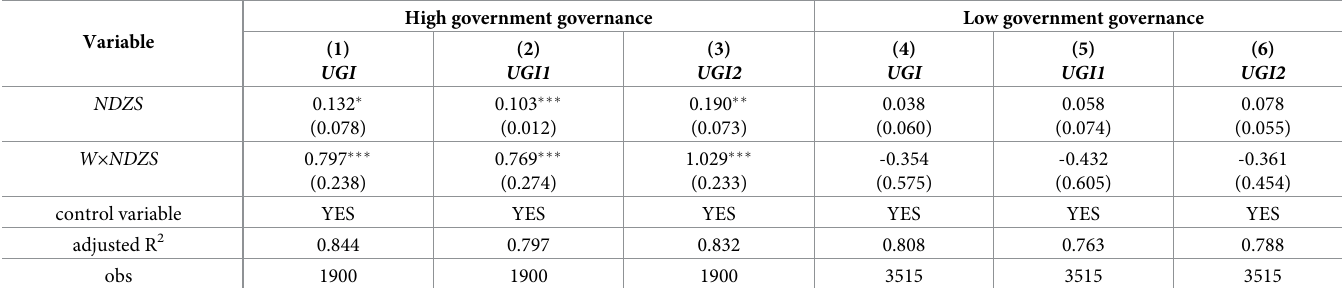
Table 7. Heterogeneity test: High government governance vs.low government governance.